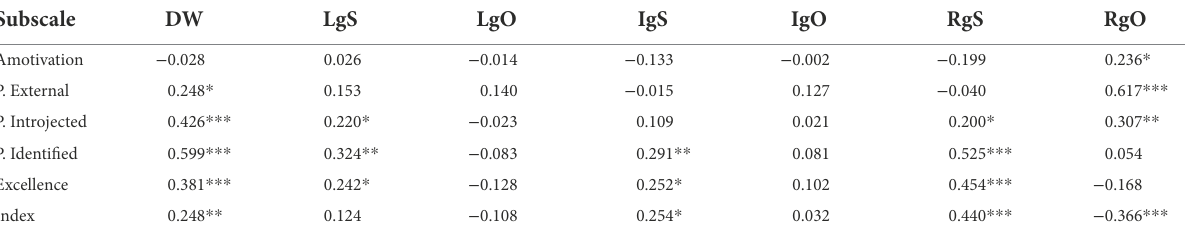
TABLE 5 Correlations between the MPSES and Questions About Performance, Study 1b. Subscale